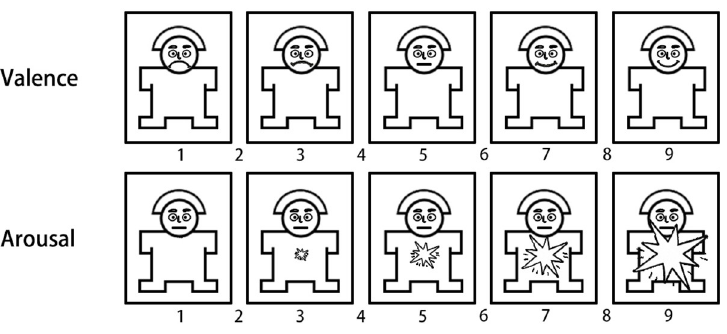
Fig 3. Schematic diagram of the SAM (Self-Assessment Manikin) scale. The Self-Assessment Manikin (SAM) was used to rate the affective dimensions of valence and arousal.